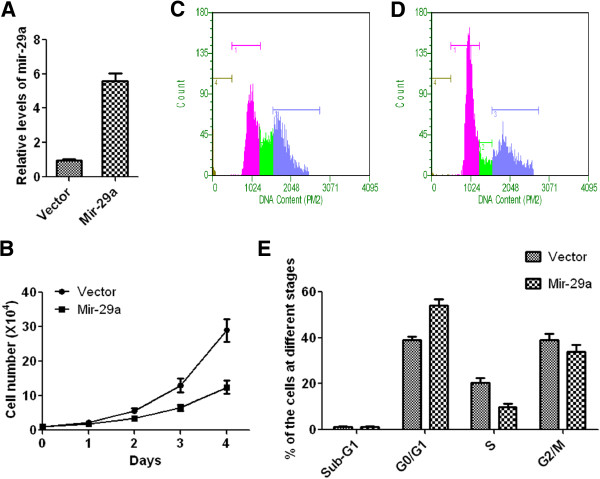
Over-expression of miR-29a in MDA-MB-453 cells inhibits growth of cells. A, relative levels of mir-29a in cells with or without mir-29a over-expression, n = 5, Mean ± SD. B, the growth curve of above cells, n = 5, Mean ± SD. C and D, representative figures of cell cycle analysis using Guava assay. E, quantitative analysis of the results of cell cycle examination, n = 5, Mean ± SD.